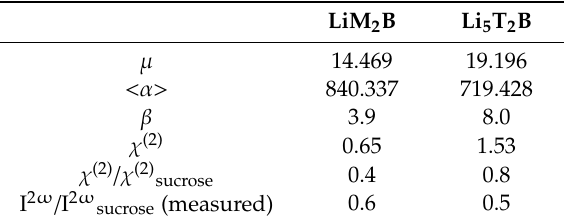
Table 2. Computed dipole moments µ (Debye), mean polarizabilities < α > (a.u.), first